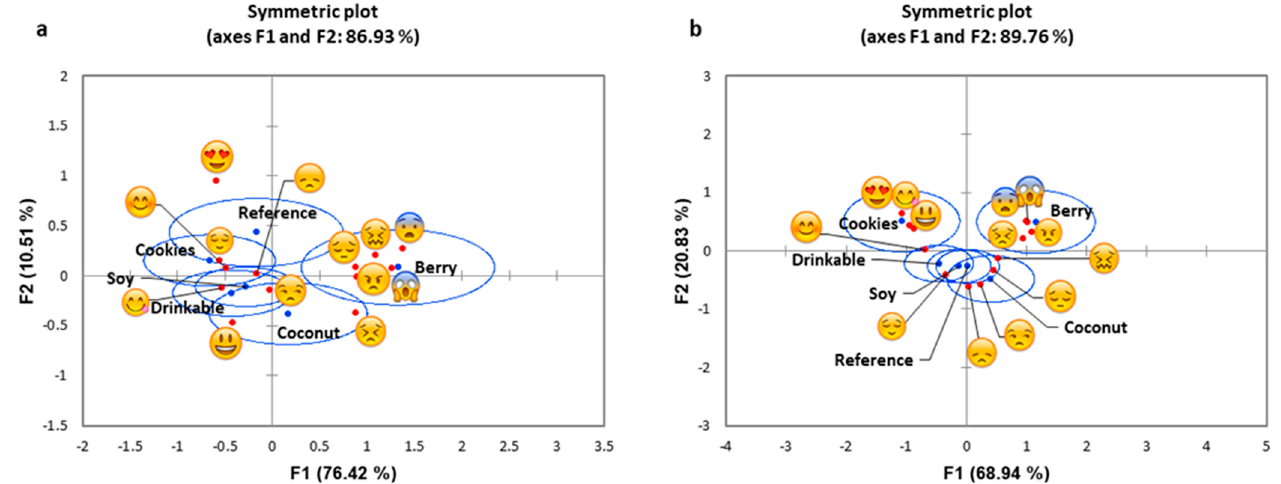
Figure 2. Correspondence analysis symmetric plots for emojis comparing for the two cultural groups: ( a ) Western consumers, ( b ) Asian consumers, with the confidence ellipses showing emojis related to each of the yogurt products.